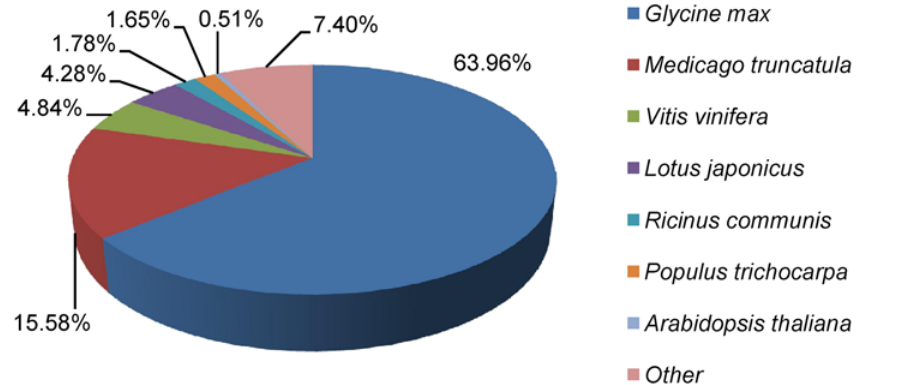
Fig 3. Species distribution of the sequences in